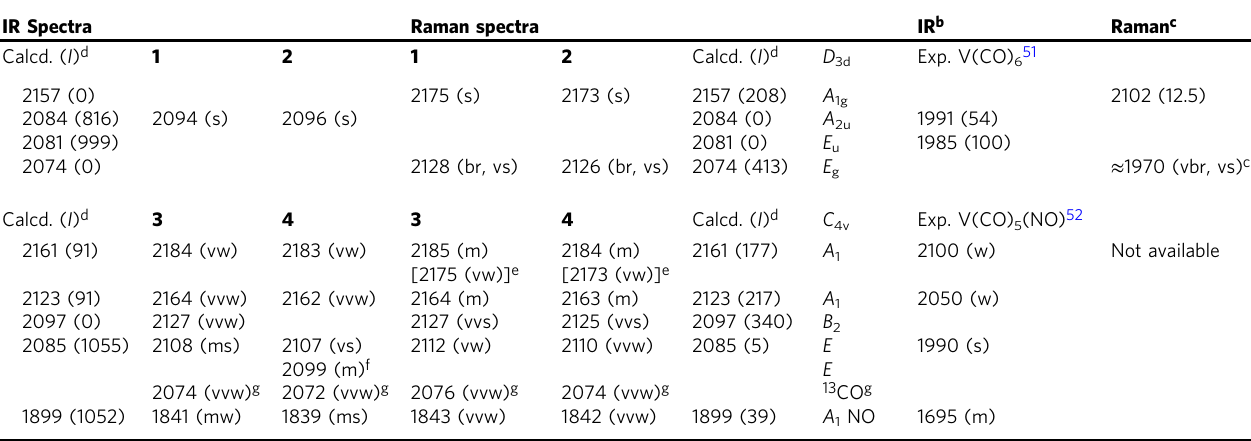
Table 2 Experimental (exp.) and calculated (calcd.) vibrational spectra of [Cr(CO) 6 ] (cid:129) + , [Cr(CO) 5 (NO)] + , and the isoelectronic vanadium analogs a IR Spectra